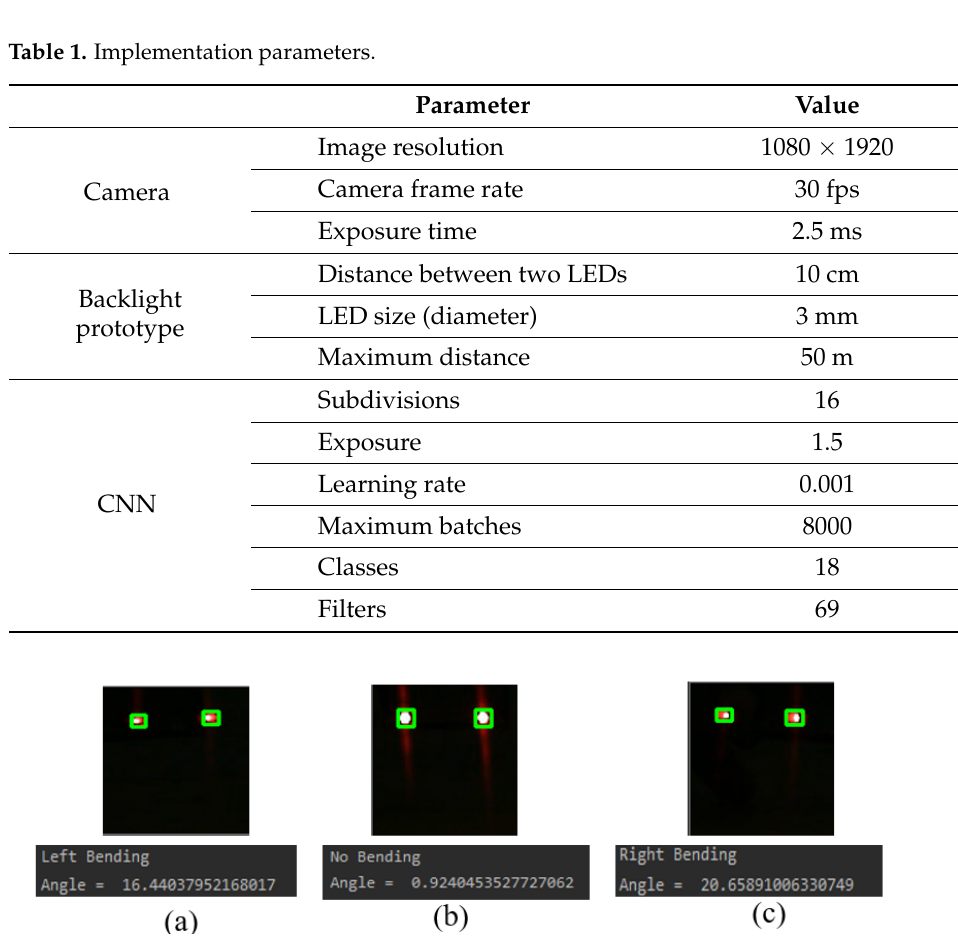
Figure 9. The projected rear LED image of FWV on the image sensor of FLV when it enters into a